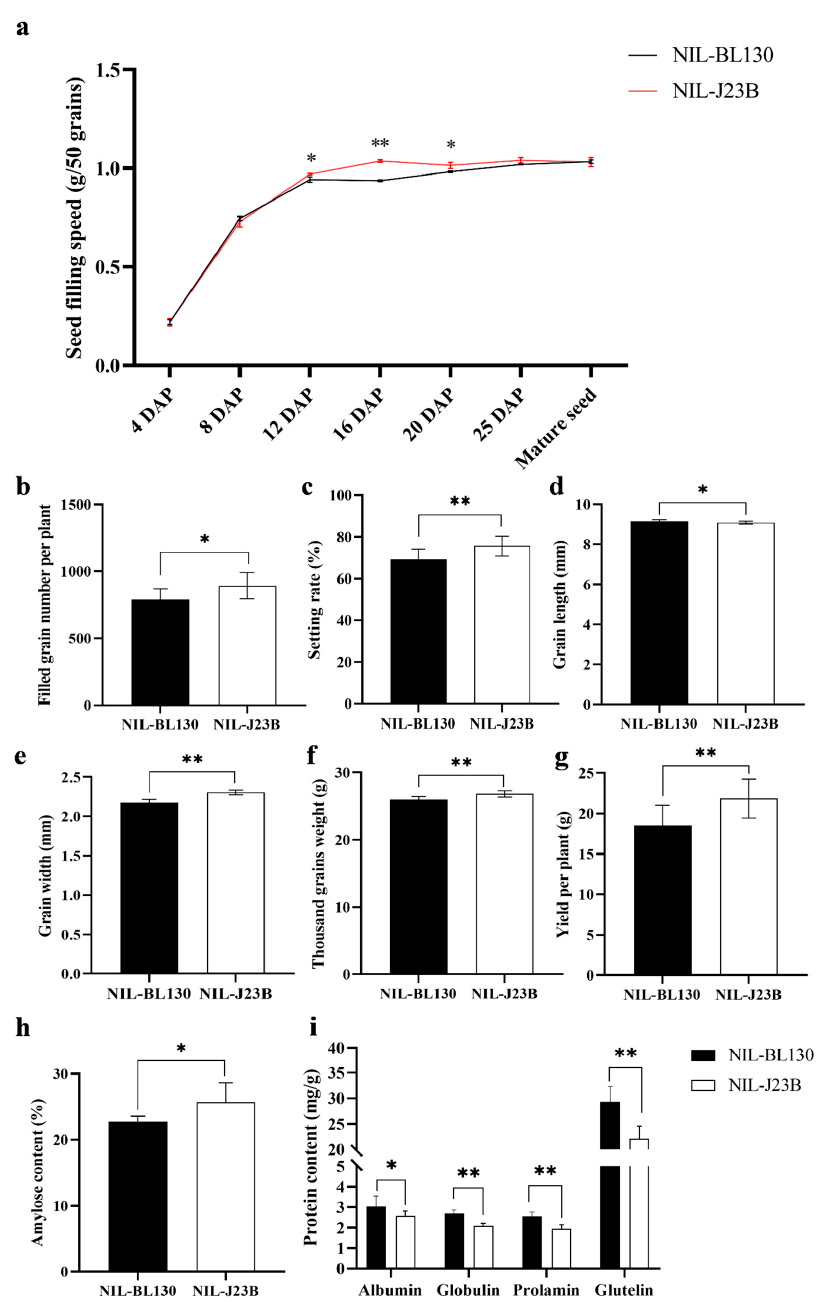
Figure 4. Trait performance of two NILs. Differences in Seed filling rate ( a ), Filling grain number per plant ( b ), Setting rate ( c ), Grain length ( d ), Grain width ( e ), Thousand grain weight ( f ), Yield per plant ( g ), Amylose content ( h ) and protein content ( i ) were analysised between two NILs. * and ** mean significant differences at p < 0.05 and p < 0.01 respectively, student’s t -tests.